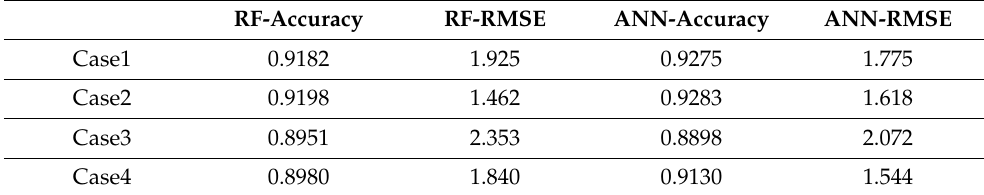
Table 5. The Accuracy and RMSE results of all cases from 11/7 to 11/14.